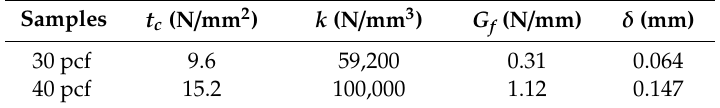
Table 2. The CZ element properties for the testing materials 30 pound per cubic foot (pcf) and 40 pcf.